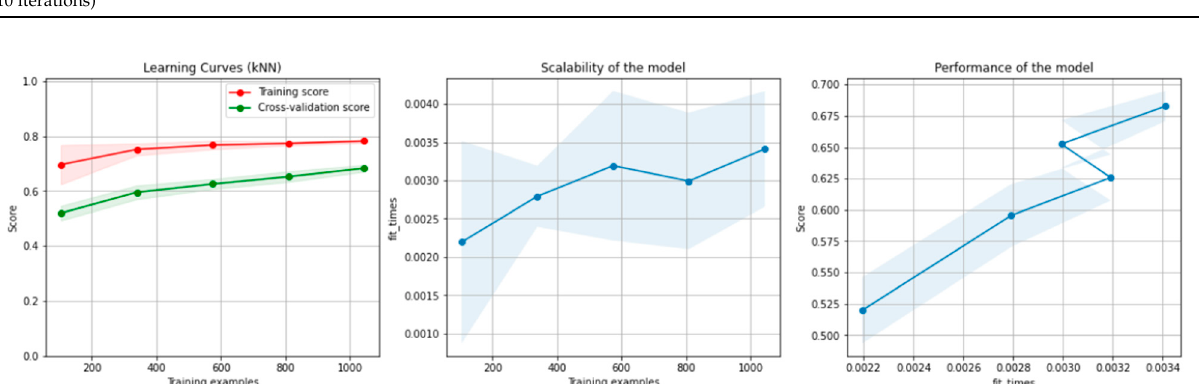
Figure 10. Learning curves, scalability and model performance for the kNN algorithm, for the non-overlapping dataset.